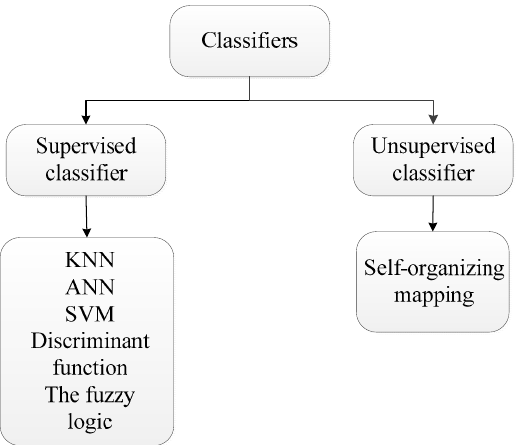
Figure 8. Kinds of classifiers. Note. KNN: K-nearest neighbor, ANN: artificial neural network, SVM: support vector machine.